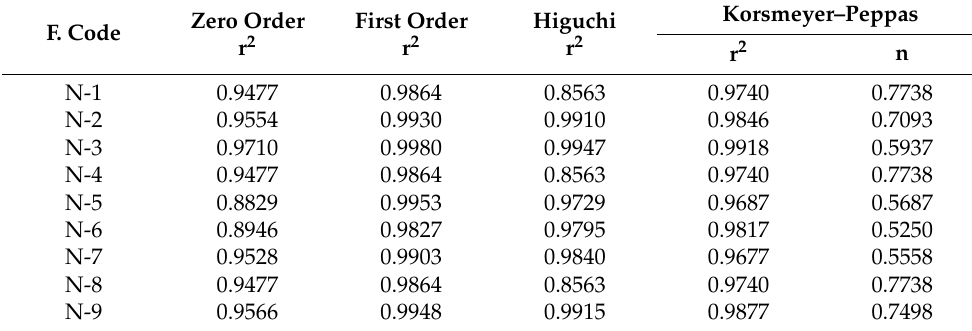
Table 3. Kinetic modeling release of Ibu from Cs/SpsCpAca